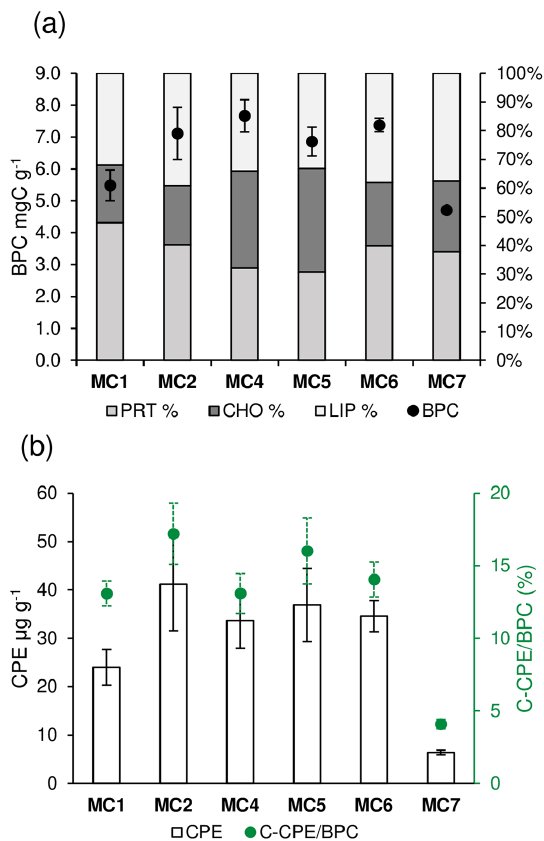
Figure 2. For each sampling station the following information is shown (data are not available at station MC3): (a) content of biopolymeric carbon (BPC, black dots) and percentage of pro- tein, carbohydrate, and lipid content (cumulative bars) and (b) the content of chloroplastic pigment equivalents (CPE, white bars) and algal fraction of BPC (C-CPE / BPC, green dots). Table 2. Foraminiferal total abundances (in number of individuals per 50cm 2 ) and diversity indexes, considering the total living fauna ( > 150µm size fraction) in the 0 to 5cm core top